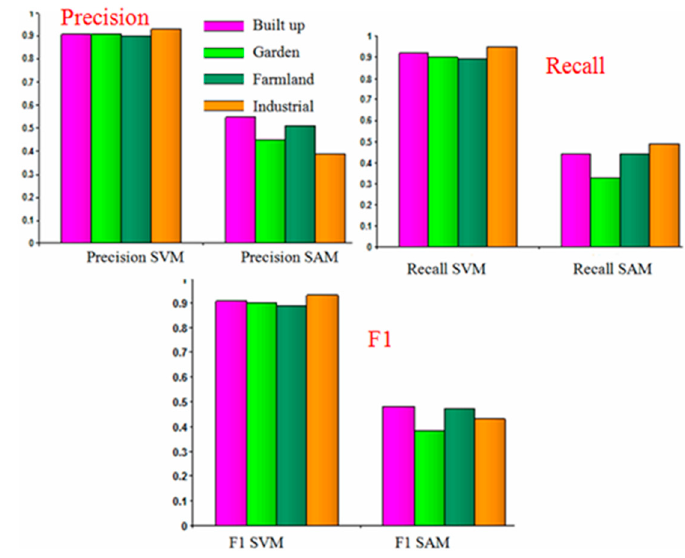
Figure 5. A comparison of the F1, precision, and recall scores for the Landsat image (15 August 2018) using SVM and SAM classifiers. and the east directions (Figures 6 and 7). Table 3. Overall accuracy (%) of the LULC maps for the years 1990, 2000, 2010 and 2018.